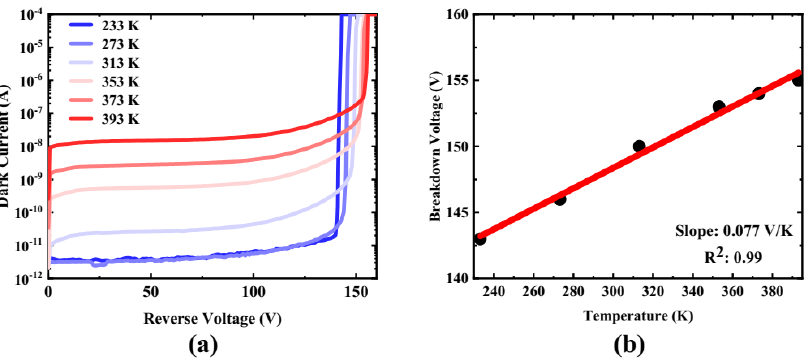
Figure 4. Temperature characteristics of the device: ( a ) dark current versus reverse voltage under different temperature; ( b ) breakdown voltage versus temperature (black dot: measured data, red line: linear fit).